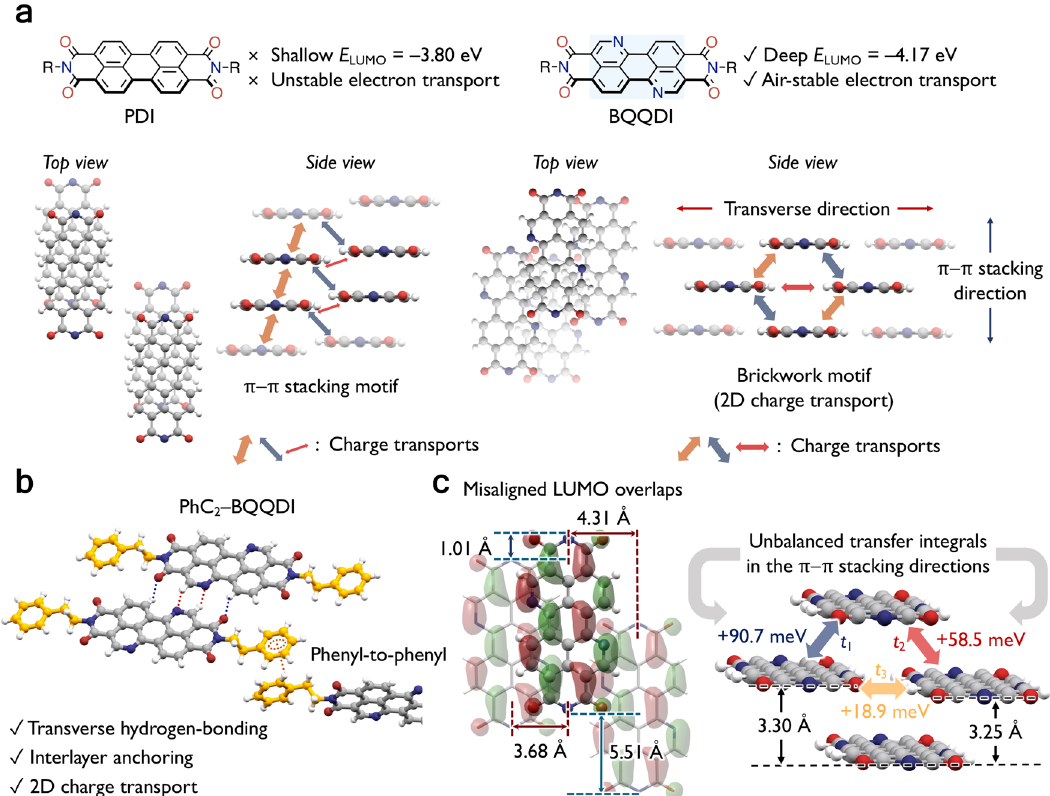
Fig. 1 Molecular features of C 8 – PDI and PhC 2 – BQQDI. a Structural, packing motif, and charge-transport comparisons between C 8 – PDI and BQQDI (LUMO energy is calculated at the B3LYP/6-31G + (d) level of theory, and arrow thickness represents the relative magnitude of transfer integrals). b Intermolecular interactions of PhC 2 – BQQDI (orange and blue arrows indicate π – π stacking interactions, and the red arrow indicates transverse interactions). c Molecular misalignment, transfer integrals, and π – π stacking distances (between planes of atoms on the BQQ core, excluding hydrogens) of PhC 2 – BQQDI.